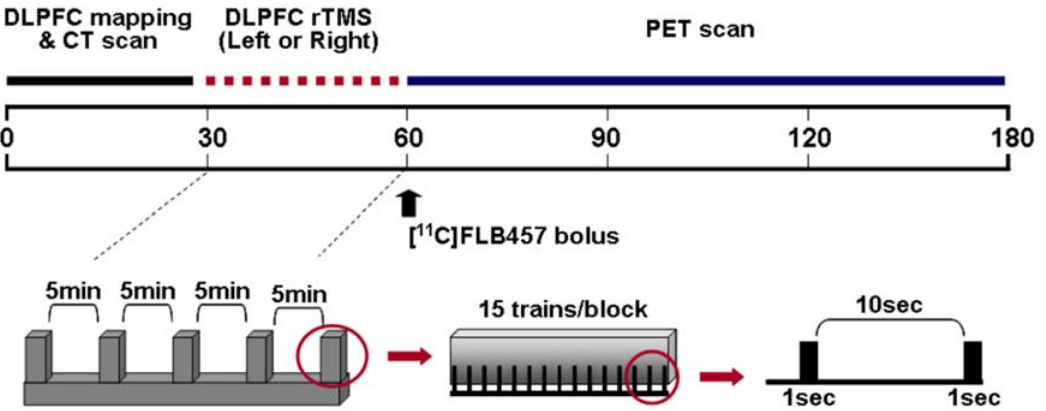
Figure 3. Timeline of the experimental setup for rTMS and [ 11 C]FLB 457 PET imaging.